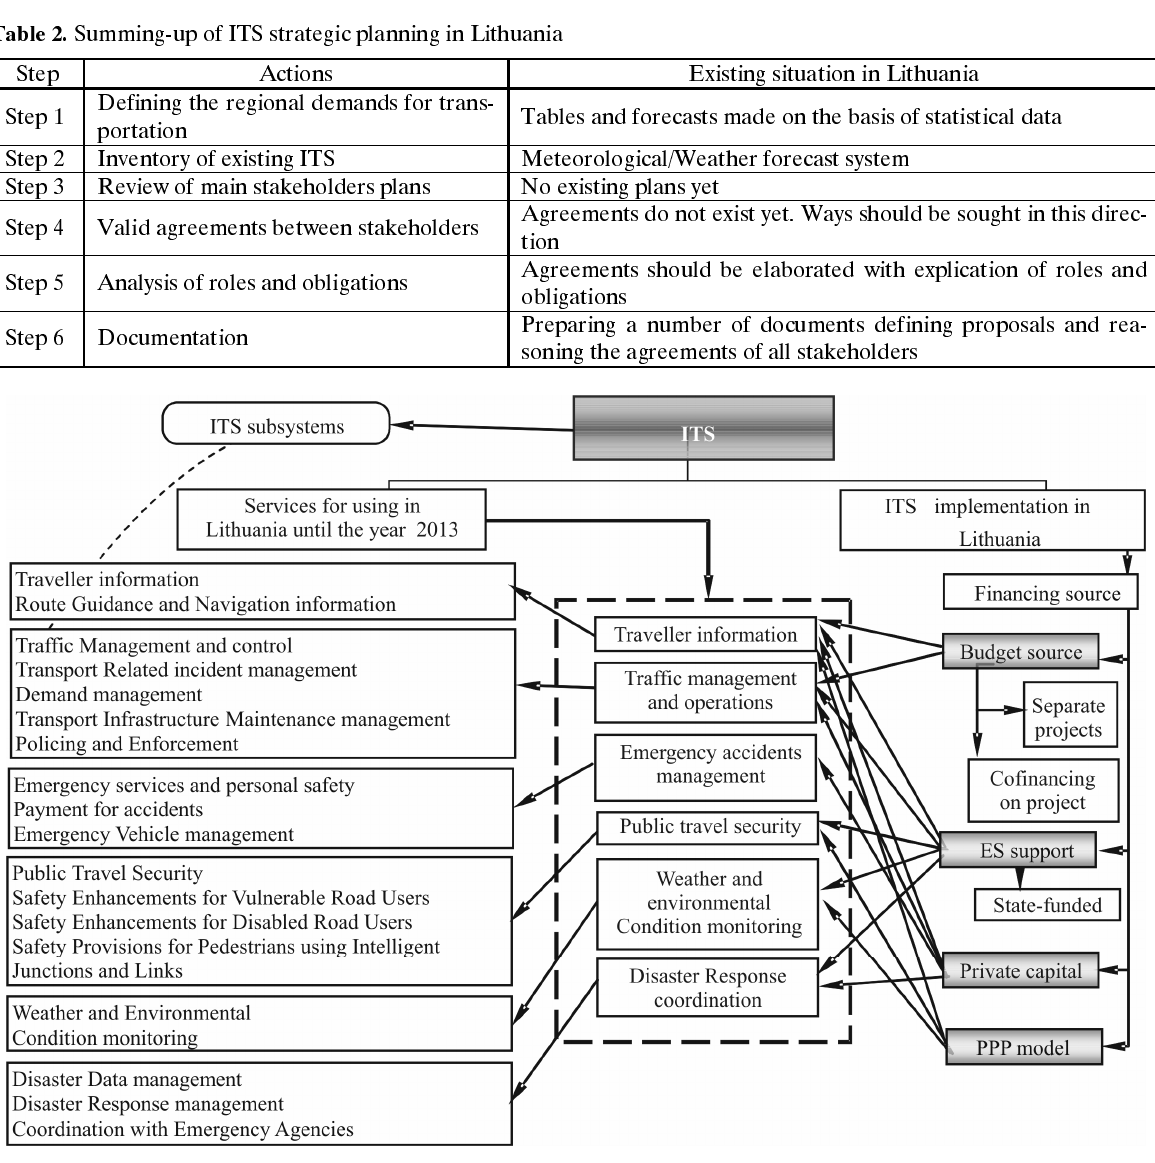
Table 2. Summing-up of ITS strategic planning in Lithuania